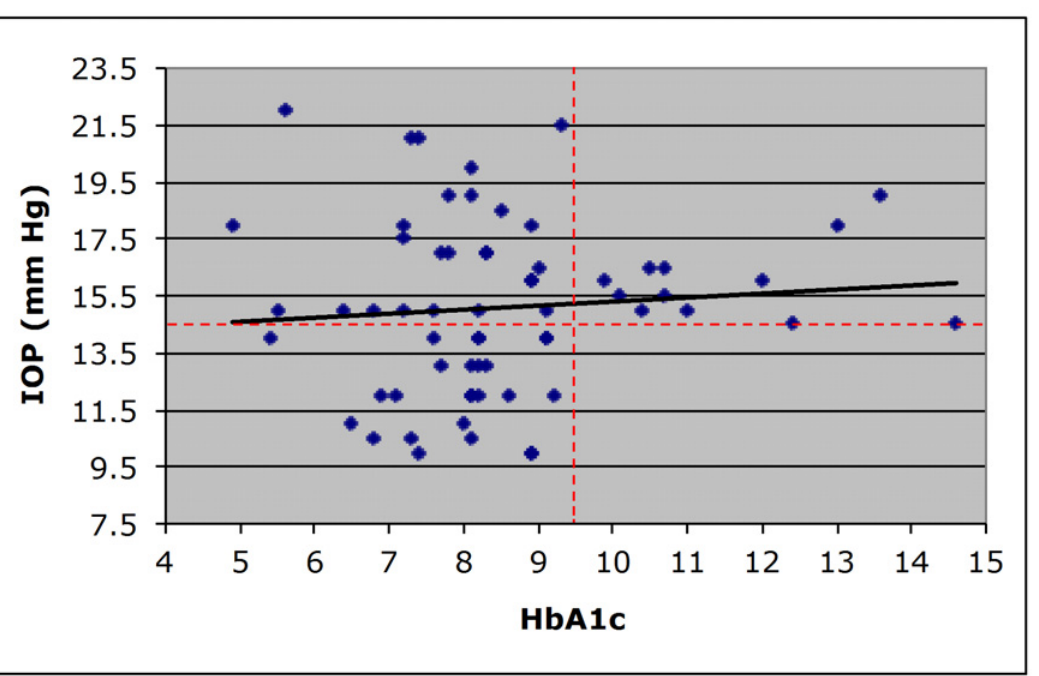
Fig 2. Plot of IOP and HbA1C with regression line representing 114 subjects. The data points representing all subjects are divided into four quadrants (dotted vertical line for HbA1C and dotted horizontal line for IOP). Linear regression plot showing diabetic patients with high HbA1c level rarely exhibit low IOP (lower right quadrant). The solid black line shows linear regression. Note, the horizontal dotted red line represents IOP at 14.5 mm Hg used as proxy population mean value.